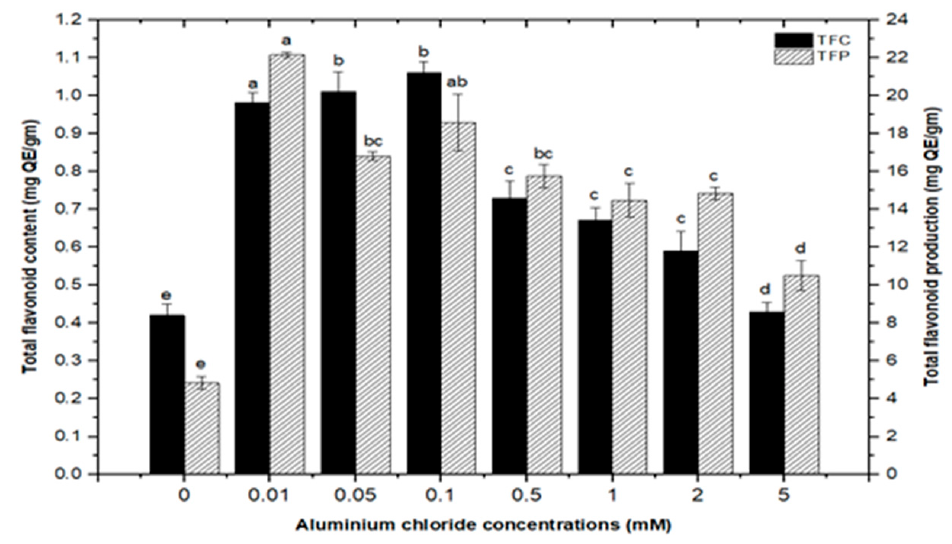
Figure 5. Total flavonoids contents and flavonoids production of F. indica calli elicited with seven different concentrations of aluminum chloride and control. All the values are mean ± SE. Bars labeled with different letters (LSD values) exhibit significant variation ( α < 0.05).